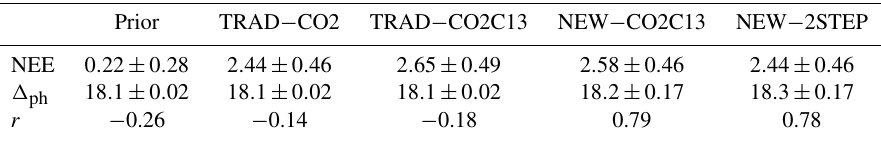
Figure 6. Summer (JJA) residuals of δ 13 C (‰) in CO 2 for 46 sites (excluding aircraft and ships) situated in the Northern Hemisphere. These sites are ordered based on the their latitudinal location; most northern site is placed at the top left (Alert, Canada) and the site nearest to the equator at the bottom left in the second part of Fig. 6 (Christmas Island, Republic of Kiribati). All residuals (simulated minus observed) are calculated from a traditional TRAD − CO2 inversion with scaled disequilibrium fluxes. Assuming a closed long-term mean budget in δ 13 C, we tested the null hypothesis that the slope of the linear regression line is zero. Sites with a trend where the p value is smaller than the significance level of 5% are shown in red, whereas the remaining sites without significant trend are shown in green. The sample uncertainty (model–data mismatch) used for the NEW − CO2C13 and NEW − 2STEP inversions is displayed by transparent gray areas. Sites marked with ** were not included in the inversions but were used for independent verification. For detailed information of the sites and their locations, we refer to the NOAA website: http://www.esrl.noaa.gov/gmd/ccgg/carbontracker/observations.php. Table 3. Northern Hemisphere land net carbon uptake (NEE, (PgCyr − 1 )) and land discrimination ( (cid:49) ph , (‰)) 11 year mean estimates, and IAV ( ± 1 σ SD) from SiBCASA (prior) and the four inversion experiments. The last row gives the correlation coefficient r between 11 annual mean NEE and (cid:49) ph values. Prior TRAD − CO2 TRAD − CO2C13 NEW − CO2C13 NEW −